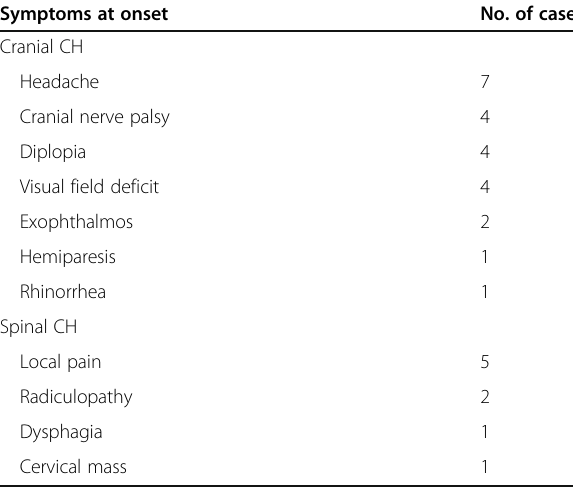
Table 1 Clinical and anatomical information about the